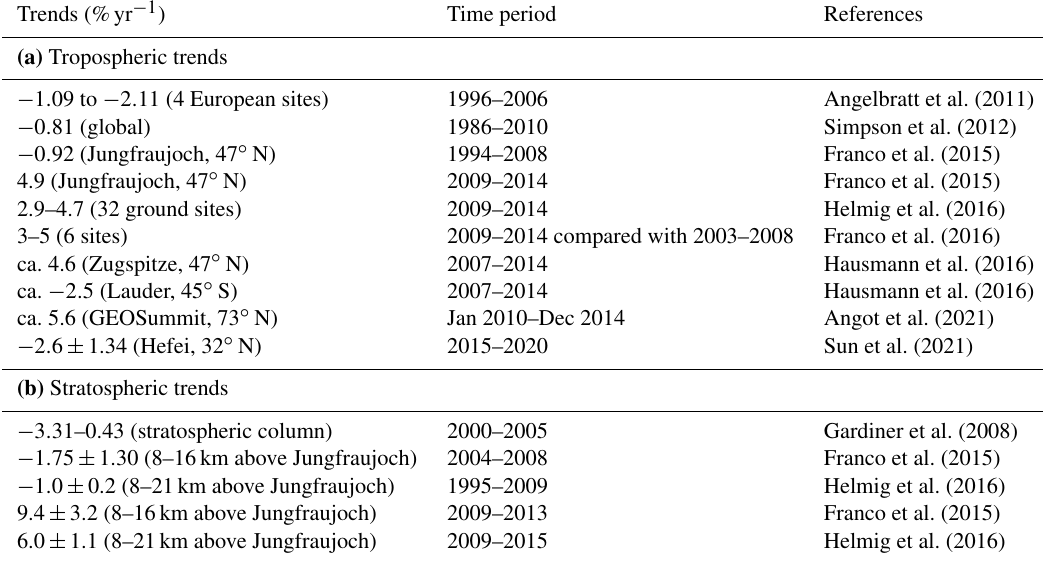
Table 1. Summary of studies reporting ethane trends in the (a) troposphere and (b) stratosphere. Parentheses in first column indicate the locations of